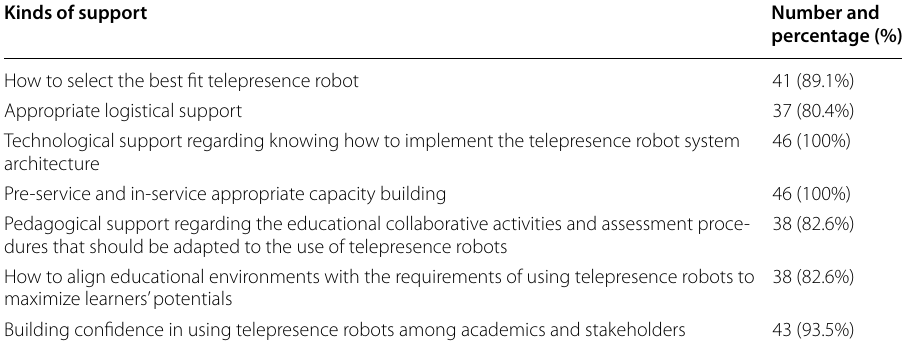
Table 10 Kinds of support that academics need in order to use telepresence robots Kinds of